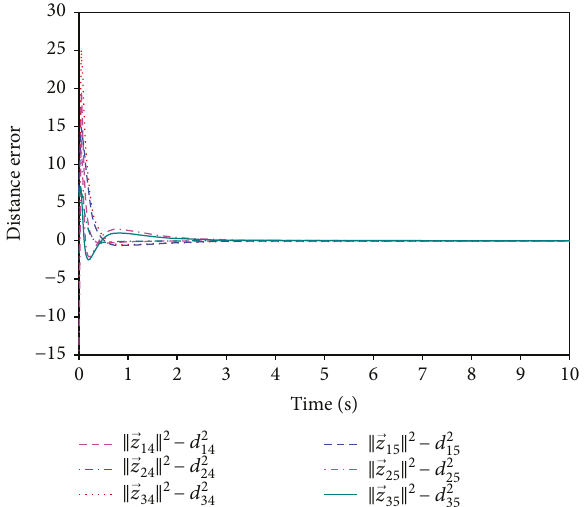
Figure 8: Distance errors: the velocity of the leader agent is in the initial coplanar